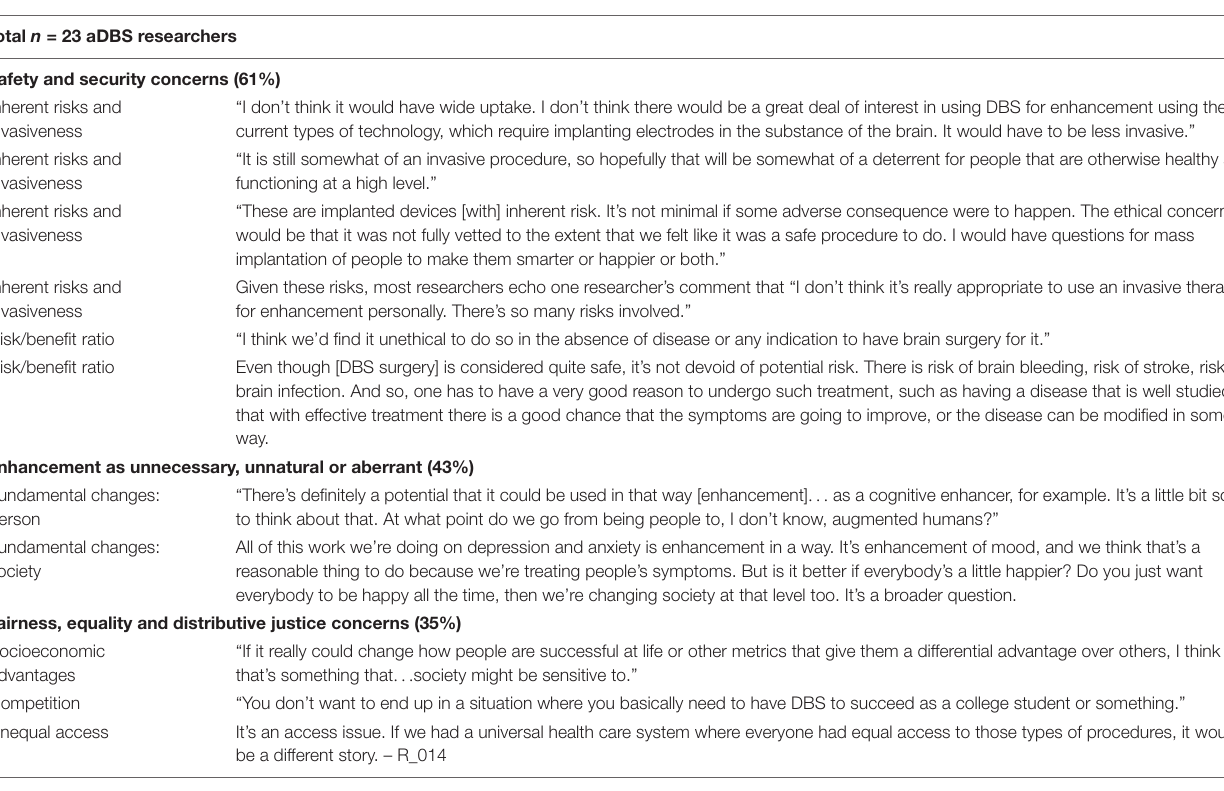
TABLE 3 | aDBS researchers’ primary ethical concerns about using aDBS for